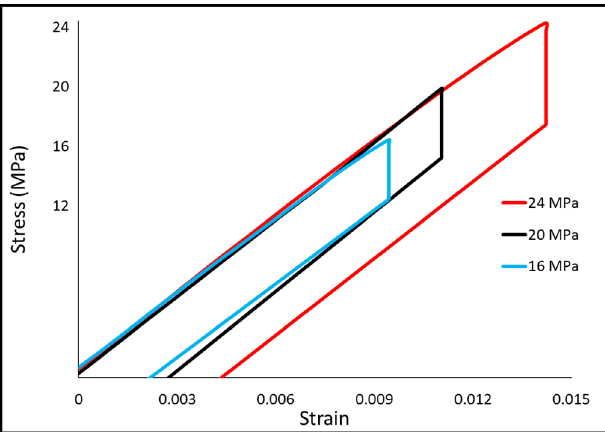
Figure 17. The hysteresis loops for SAC305 joints cycled with different stress amplitudes at 10 s dwelling.